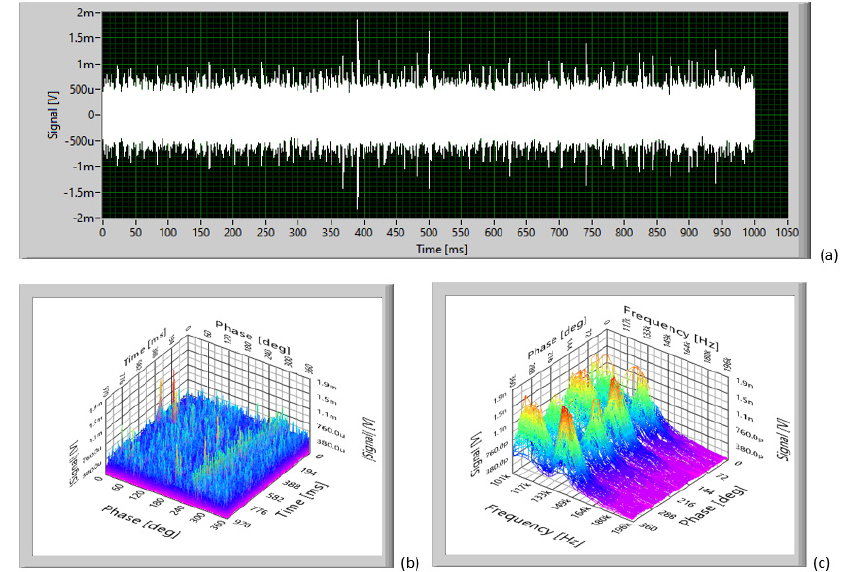
Figure 5. Acoustic image of a selected AE signal from area AE-1 within the map from Figure 4a (after filtration of the AE signal within the 100–200 kHz band): ( a ) transient signal; ( b ) phase-time characteristic; ( c ) averaged Short-Time Fourier Transform (STFT) spectrogram. AE signal parameters: ADC = − 3020, U pp = 3.68 mV, U rms = 0.15 mV.